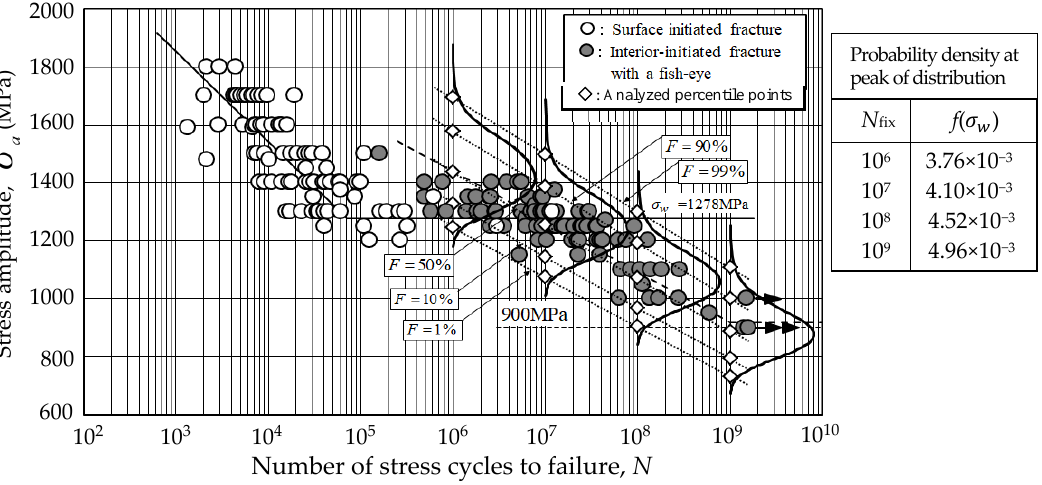
Figure 11. Fatigue strength distributions and P-S-N curves in very high cycle regime.